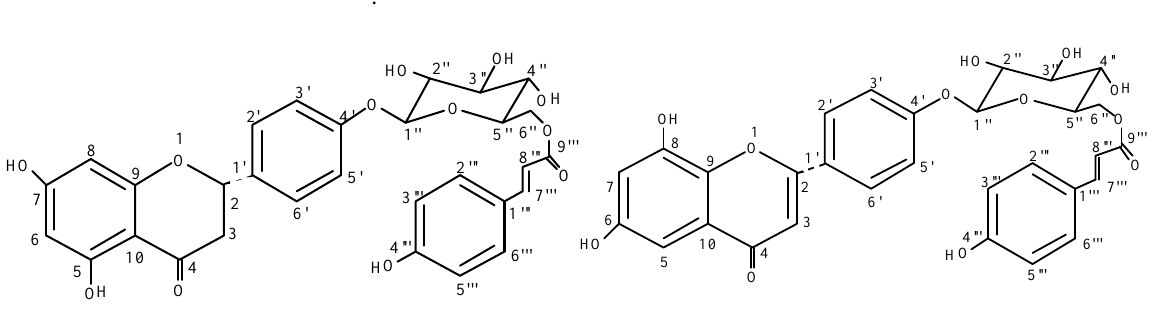
Figure 1. Structures of leufolins A ( 1 ) and B ( 2 ).